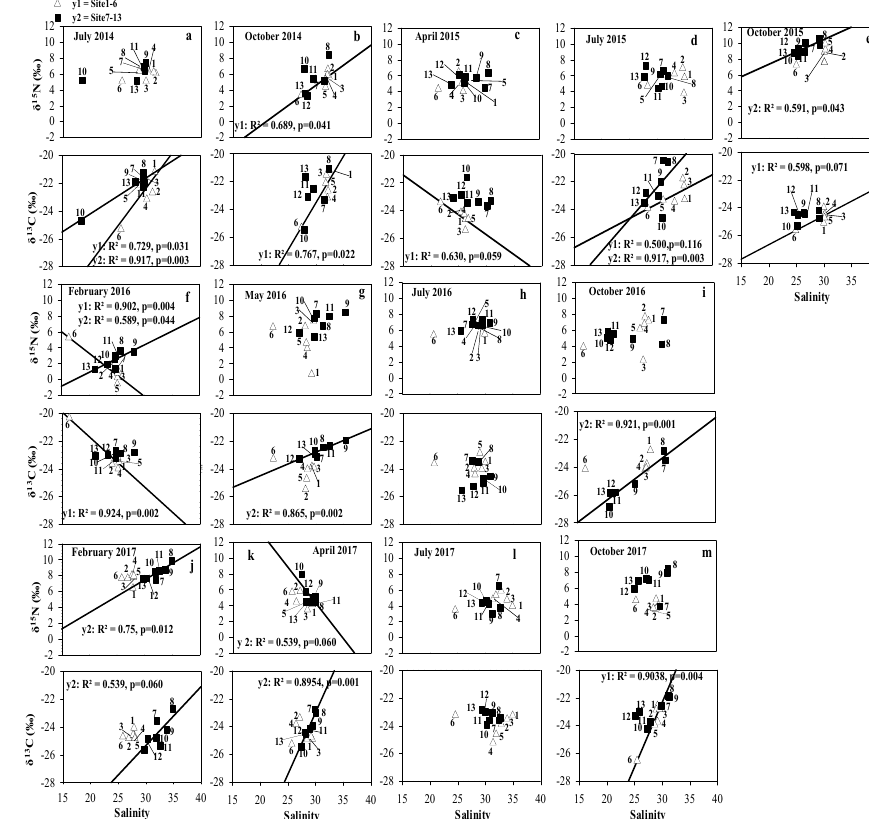
Figure 6. Relationships between salinity and δ 13 C, δ 15 N SPOM values in the Maryland Coastal Bays (July 2014—October 2017). Regression lines are shown only for significant relationships between salinity and δ 13 C, δ 15 N SPOM values. Shown for each month are figures for δ 15 N values (above) and δ 13 C values (below) plotted against salinity. Open triangles denote values for sites 1–6; solid squares are for sites